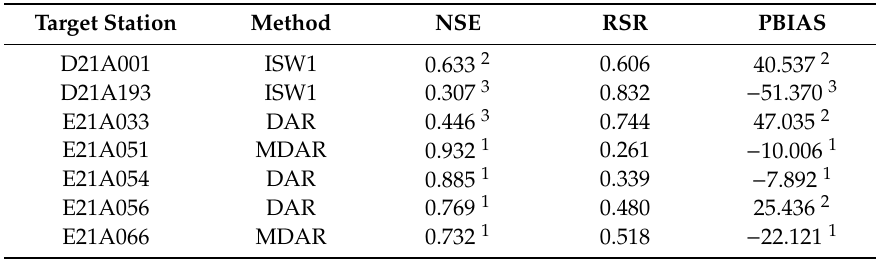
Table 14. Performance evaluation of the best statistical method without the MA for each target station in the Upper Euphrates Basin.